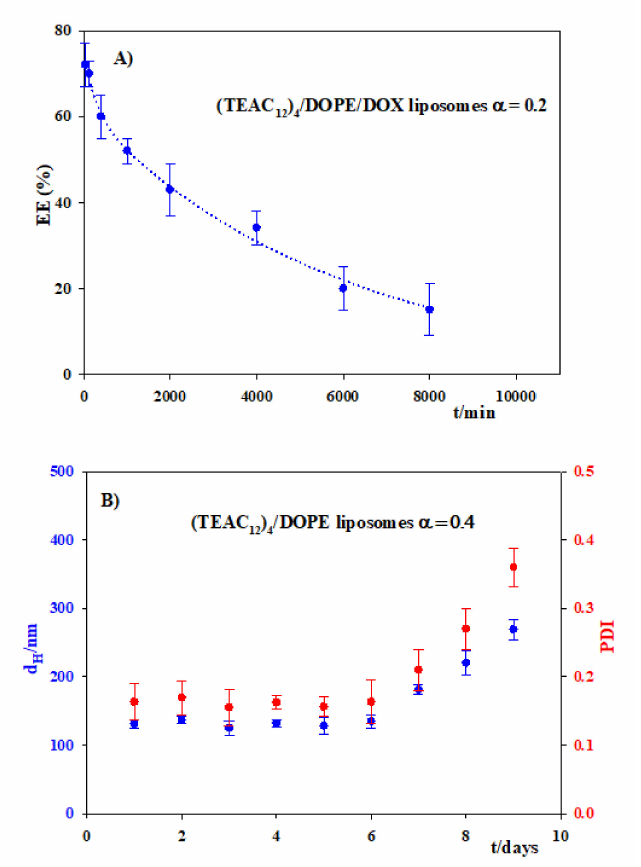
Figure 12. Variation of the hydrodynamic diameter, d H , and of the polydispersity, PDI, with time for (TEAC 12 ) 4 /DOPE liposomes at 310 K. ( A ) α = 0.2; ( B ) α = 0.4.